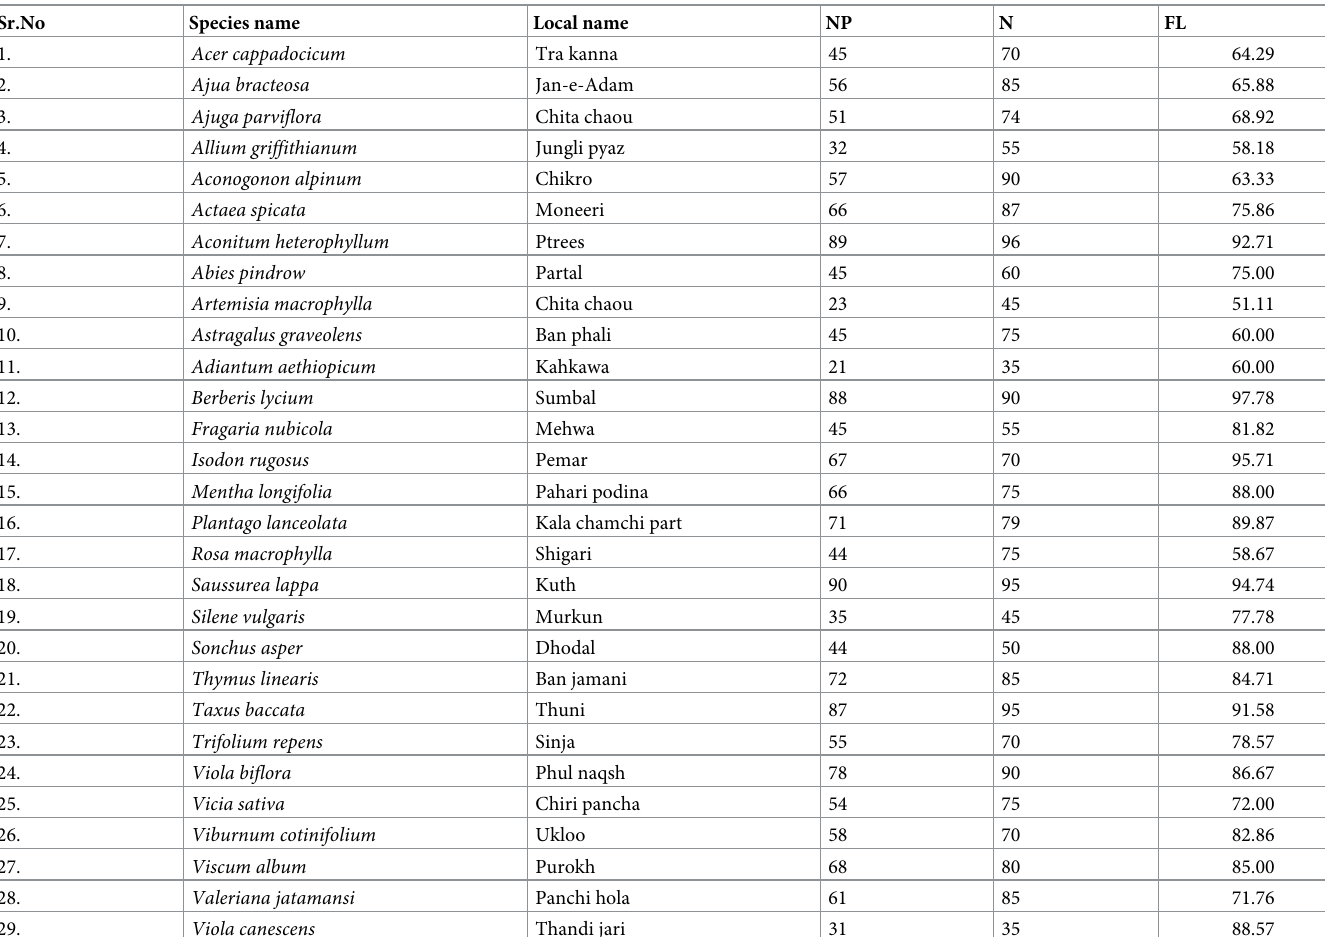
Table 5. Fidelity level of plants in study area of two villages Dawarian and Ratti Gali of AJK,